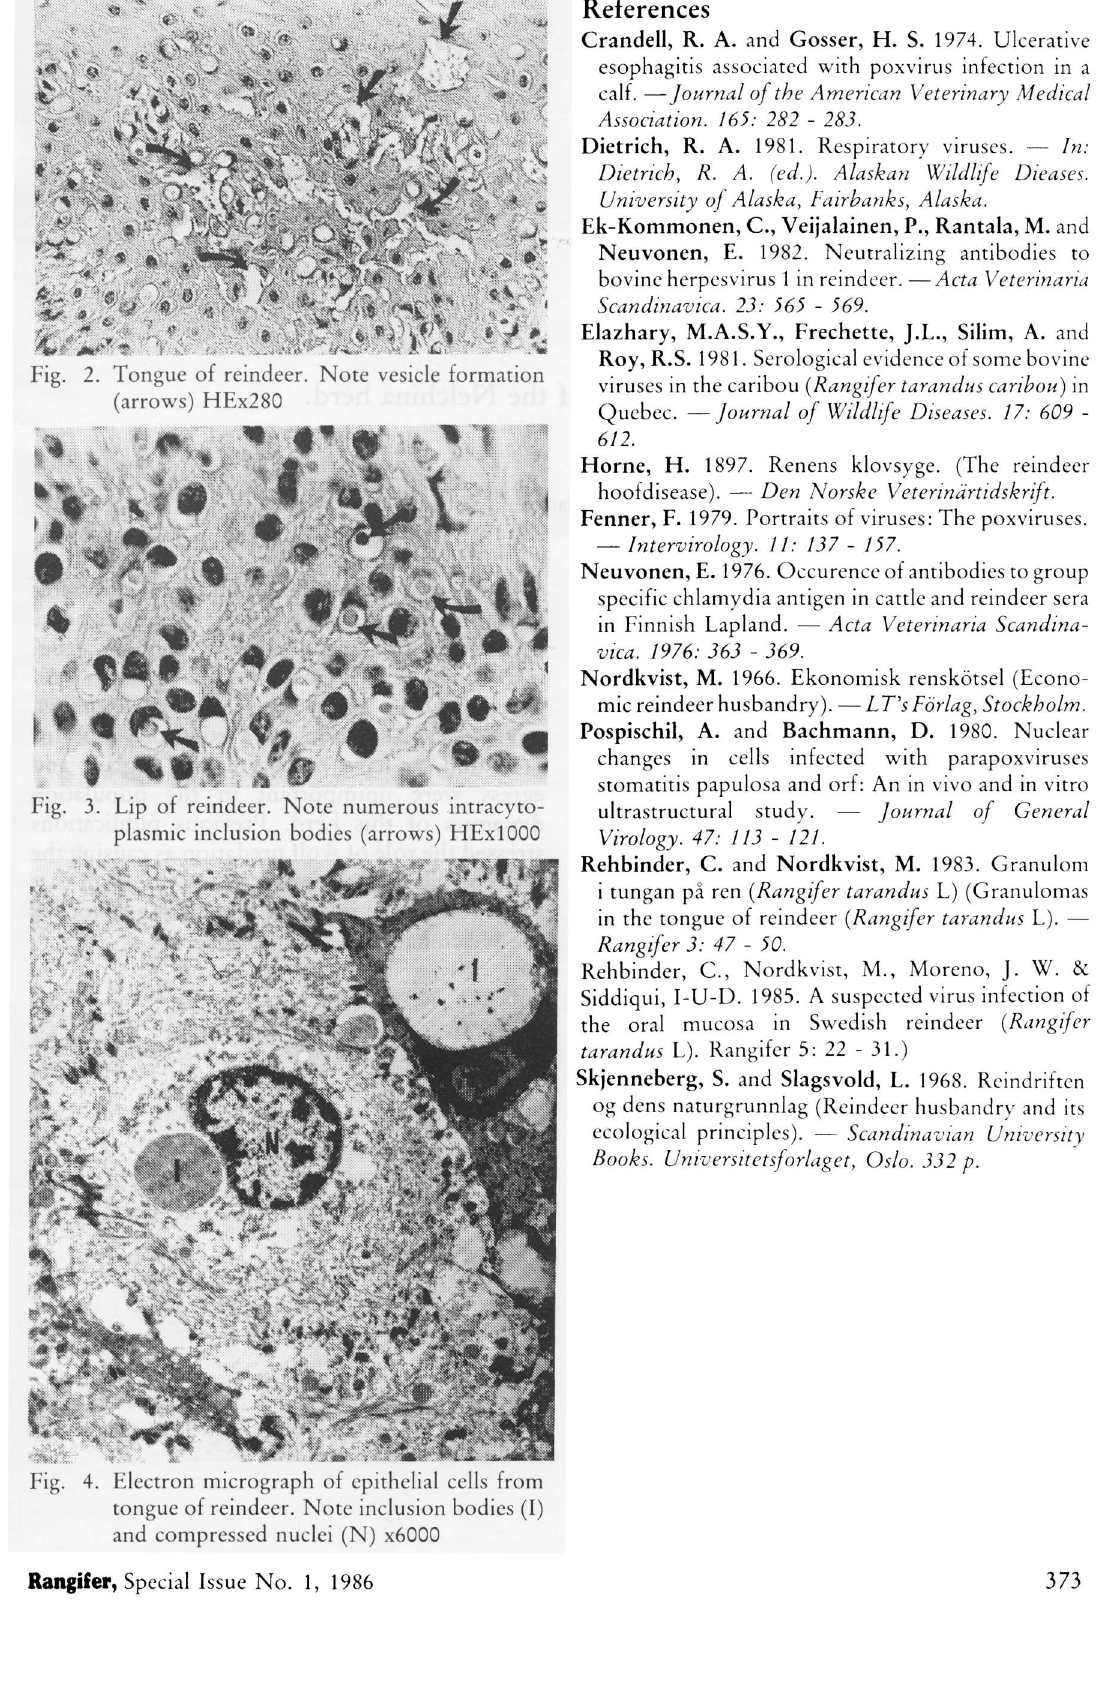
Fig. 2. Tongue of reindeer. Note vesicle formation (arrows) HEx280